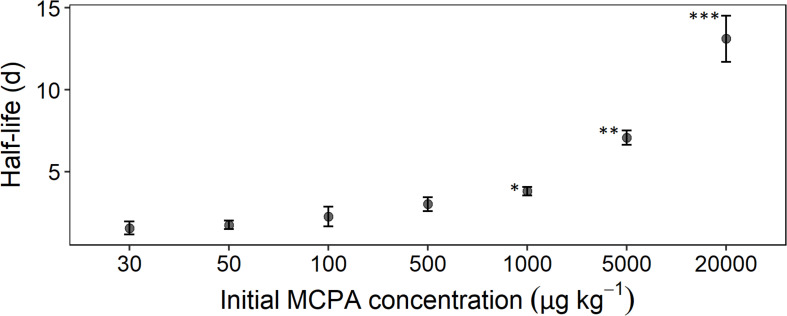
Half-life time as a function of initial concentration calculated according to Eq. 8. Error bars represent the standard deviation. The statistical comparison is always checked against the concentration treatment with 30 μg. Asterisks indicate p-values smaller than *p ≤ 0.05, **p ≤ 0.01, and ***p ≤ 0.001 (n = 3).